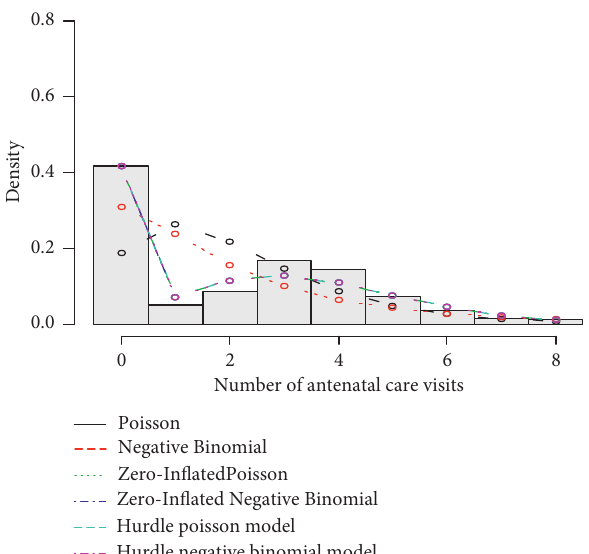
Figure 2: Histogram of the number of ANC visits with overlaid predicted probabilities from each count regression model.